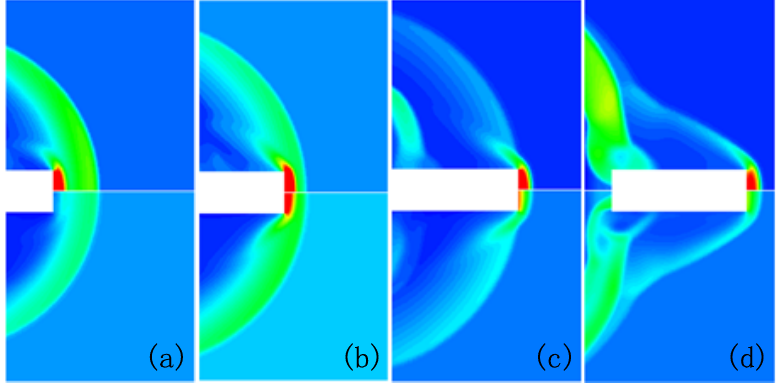
Figure 8. Bow shock-wave development process ahead the projectile. ( a ) t = 0.590 ms; ( b ) t = 0.671 ms; ( c ) t = 0.736 ms; ( d ) t = 0.989 ms.